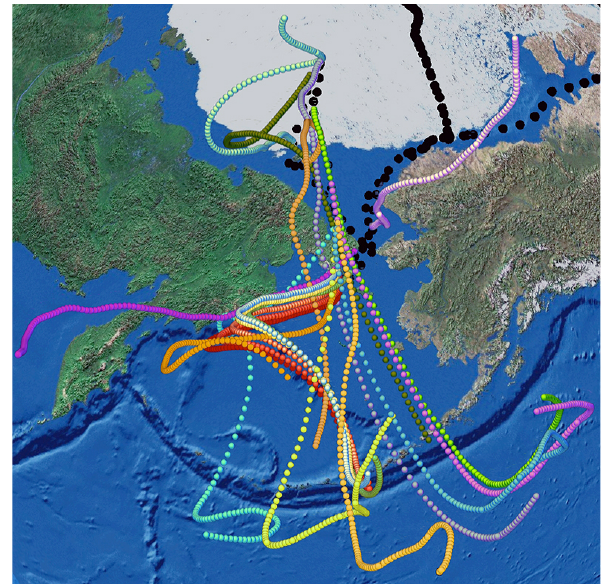
Figure 3 . Cruise track illustrated by ship’s position every 6 h (black dots) and for the two first weeks of August plots of selected five-day back-trajectories starting at 100-1,800 m above sea Fig. 3. Cruise track illustrated by ship’s position every 6 h (black level. The offset in starting elevation was chosen individually to produce a purposeful stable dots) and for the two first weeks of August plots of selected five- trajectory lacking of significant ground contact. Concerning the TGM, Hg 0 ; CO pollution event described in Section 3.1.2., trajectories with 6 h interval starting times are depicted (reddish day back-trajectories starting at 100-1,800 m above sea level. The coloured). The snow/ice coverage shown in the image does not represent the actual distribution during the cruise. offset in starting elevation was chosen individually to produce a pur- poseful stable trajectory lacking of significant ground contact. Con- cerning the TGM, Hg 0 ; CO pollution event described in Sect. 3.1.2, trajectories with 6 h interval starting times are depicted (reddish coloured). The snow/ice coverage shown in the image does not rep- resent the actual distribution during the